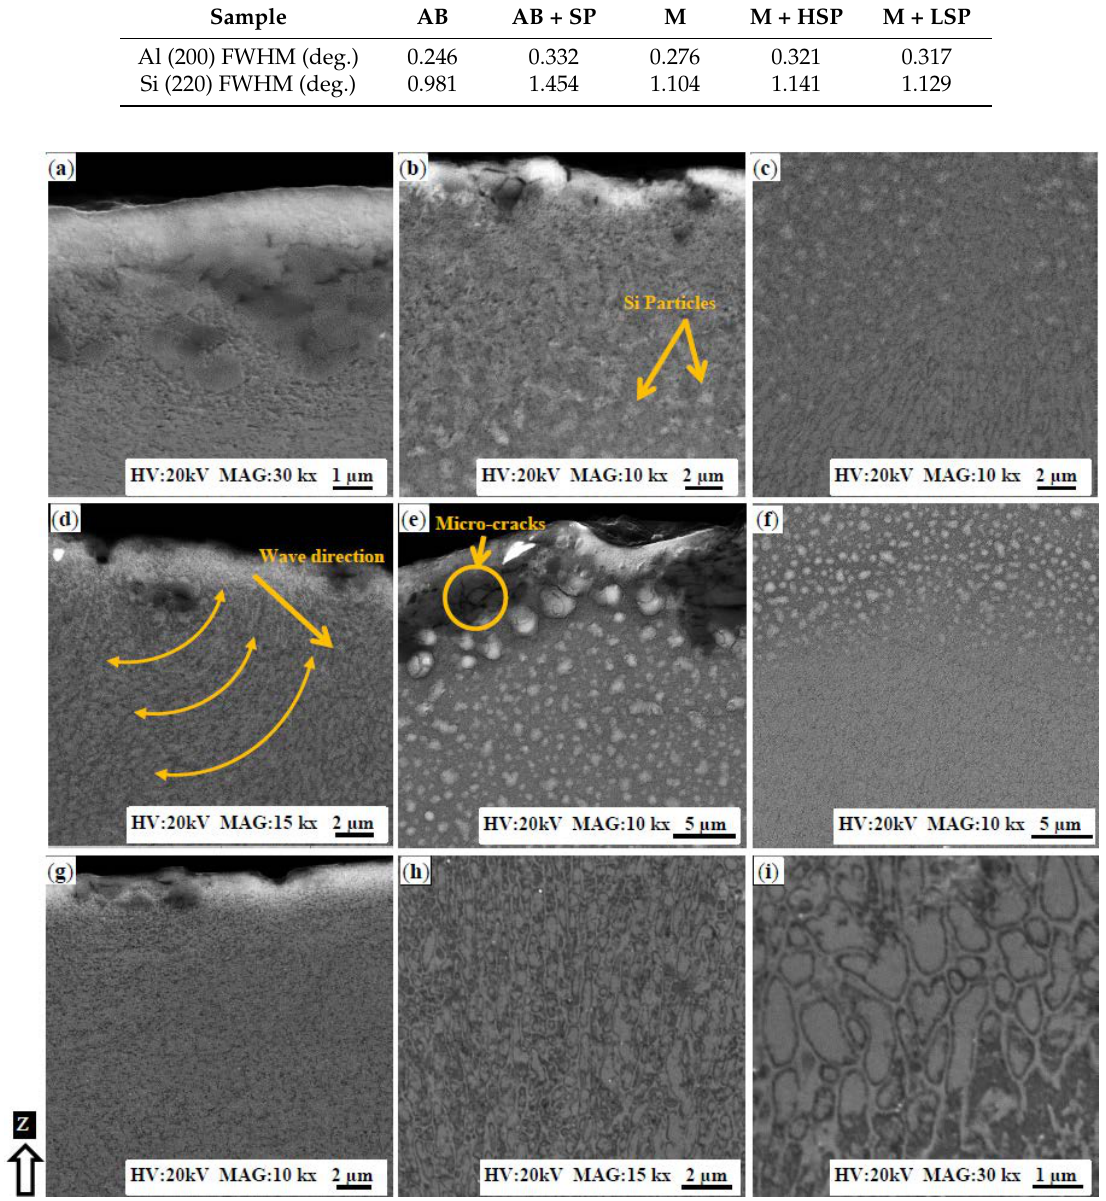
Figure 8. Microstructure evolution after the shot peening of the AlSi10Mg sample under different magnifications: ( a – c ) AB + SP; ( d – f ) M + HSP; and ( g – i ) M + LSP.